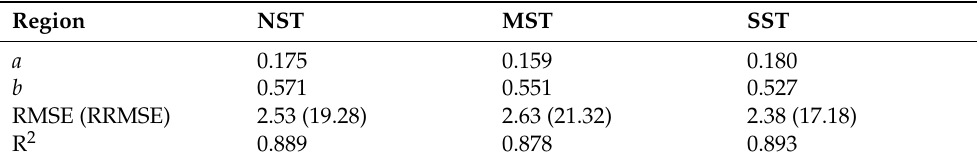
Table 2. Fitted coefficients a , b , RMSE (MJ m − 2 day − 1 ), RRMSE (%), and R 2 between observed daily global solar radiation and calculated daily global solar radiation for the study regions. Region NST MST